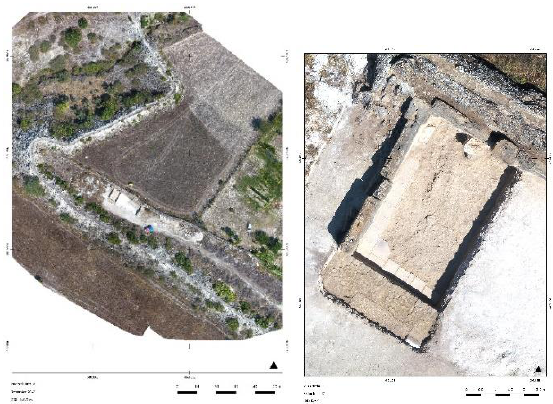
Figure 9. (left) 0.017 m per pixel orthophoto showing the two parallel channels flowing to north. (right) the 0.004 m resolution orthophoto of the basin.